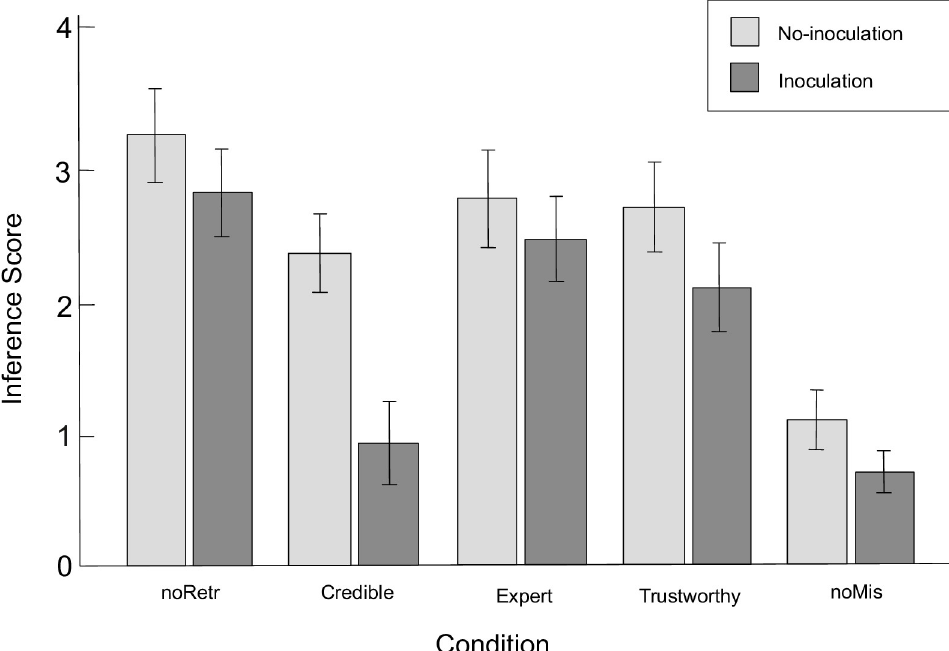
Fig 1. Inference scores across conditions. noRetr No-retraction condition; Credible credible source condition (high in trustworthiness and in expertise); Expert expert source condition (high in expertise, low in trustworthiness); Trustworthy trustworthy source condition (high in trustworthiness, low in expertise); noMis No-misinformation condition. Error bars represent 95% confidence intervals.